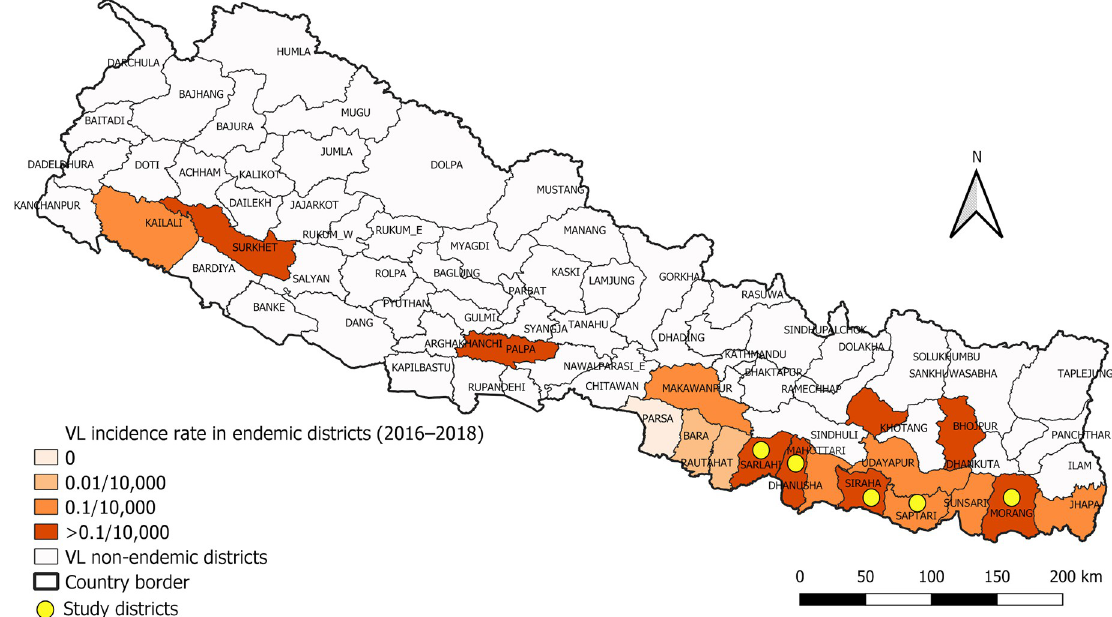
Fig 1. Map of Nepal showing visceral leishmaniasis endemicity and the locations of the study districts. The map was produced with QGIS (version 3.10) with open access shapefile (New political and administrative boundaries Shapefile of Nepal—Datasets—Open Data